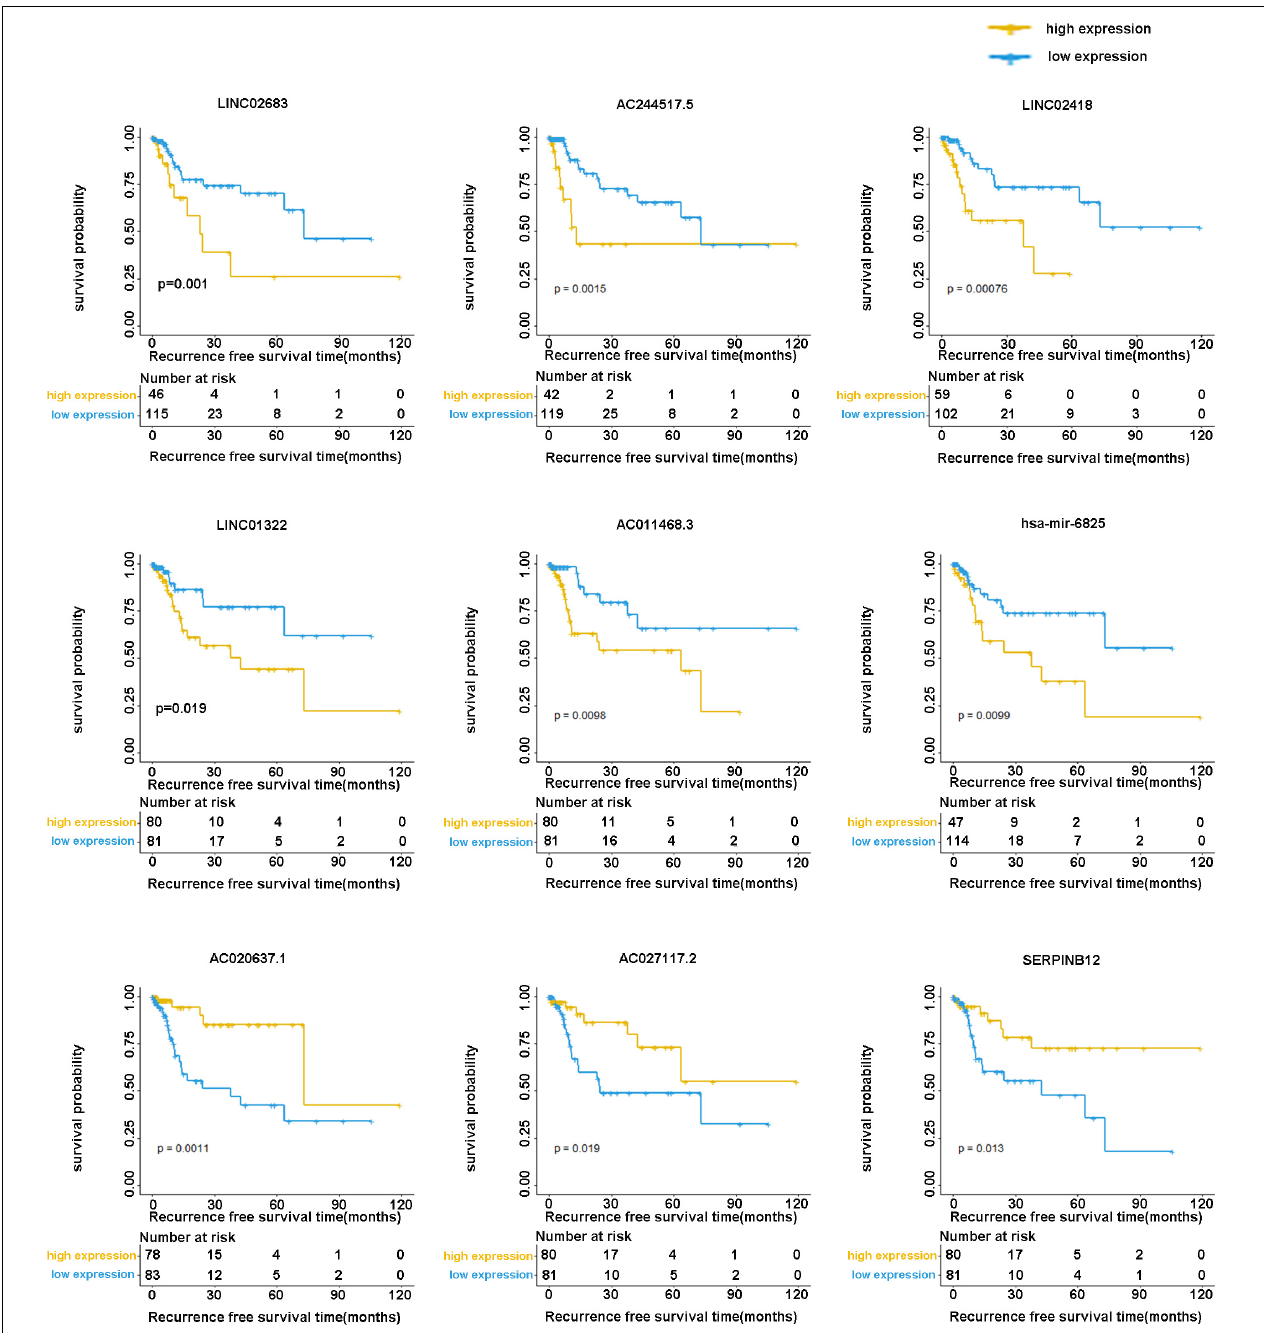
FIGURE 3 | Kaplan-Meier analysis of RFS with nine genes (including LINC02683, AC244517.5, LINC02418, LINC01322, AC011468.3, hsa-mir-6825, AC020637.1, AC027117.2, and SERPINB12) in stage I-IIIA